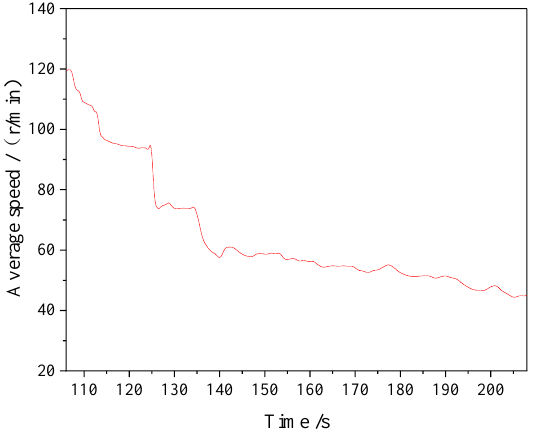
Figure 10. Average rotational speed of the intermediate shaft. Under the set working conditions, the diesel engine was tested for torsional vibration at a reduced speed, and its speed was reduced from 525 r/min to 220 r/min. After signal processing and calculation analysis, it can be seen from Figure 10 that when the diesel engine speed is 226 r/min, the torsional vibration of the intermediate shaft is the largest, and the amplitude of the maximum torsional vibration is 0.1202 ◦